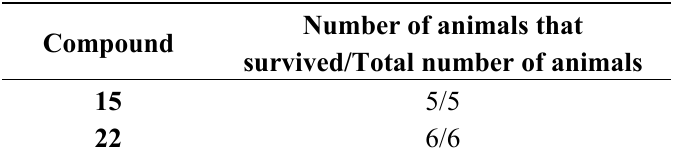
Table 2. Preliminary multidose toxicity study of compounds 15 and 22 a .